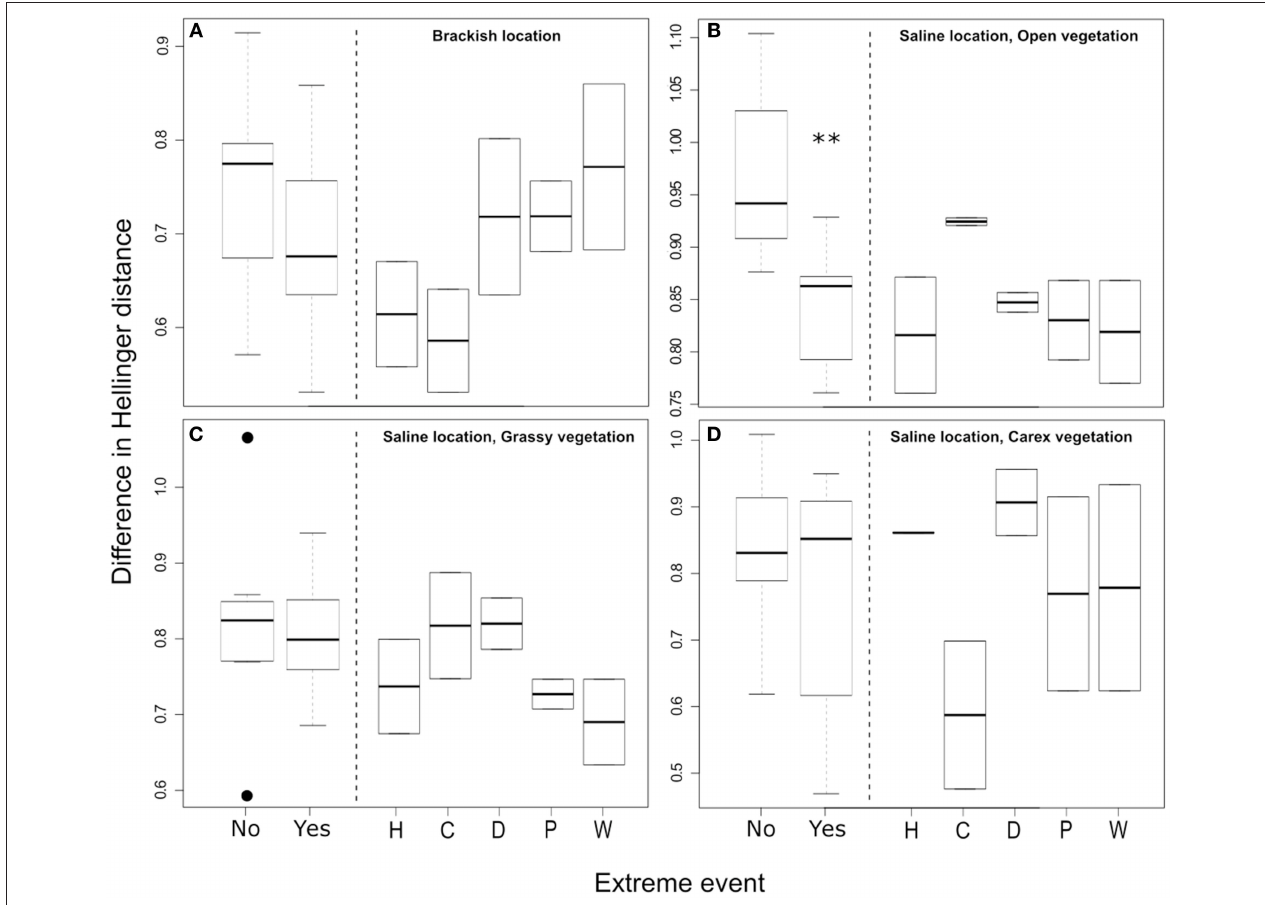
FIGURE 3 | Box plots of the Hellinger distances (i.e., Euclidean distance on Hellinger transformed species data) between the centroids of two subsequent sample dates for the (A) brackish location, (B) saline location with open vegetation, (C) saline location with grassy vegetation, and (D) saline location with Carex vegetation. For each time interval, we defined if an extreme event of any type took place (e.g., No/Yes in the left hand side of the panels) by the criteria summarized in Table 2. No events took place in seven time intervals, and there were nine intervals where events did occur. On the left hand side, boxplots indicate the median with 1st and 3rd quartile ranges, whiskers indicate the minimum and maximum values within 1.5x the interquartile range. Dots indicate values falling outside of this range. On the right hand side, the upper and lower box limits indicate the absolute values, with the central line indicating their mean. **Indicate significance at the P < 0.01 level. The extreme events were further split in the right hand side of the panel, with letters indicating the different types of extreme events. H, Heat; C, Cold; D, Drought; P, Heavy precipitation; and W, High sea water level. The individual extreme events were not statistically tested as each type of event only occurred